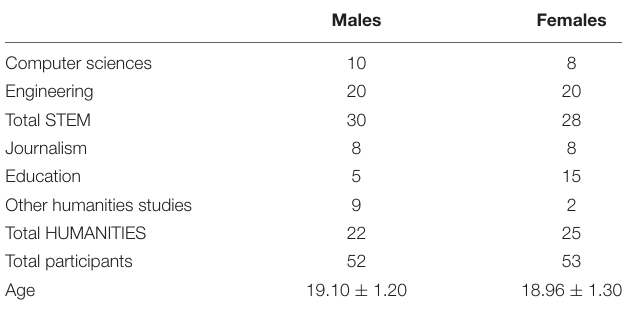
TABLE 1 | The sample’s demographic and academic